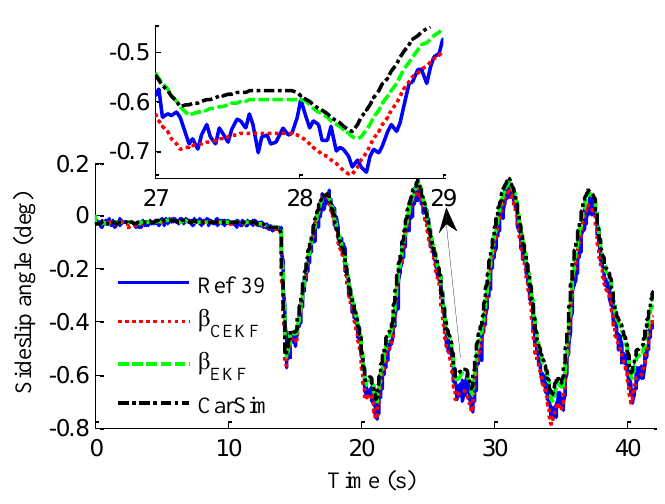
Figure 25. Estimation of sideslip angle.